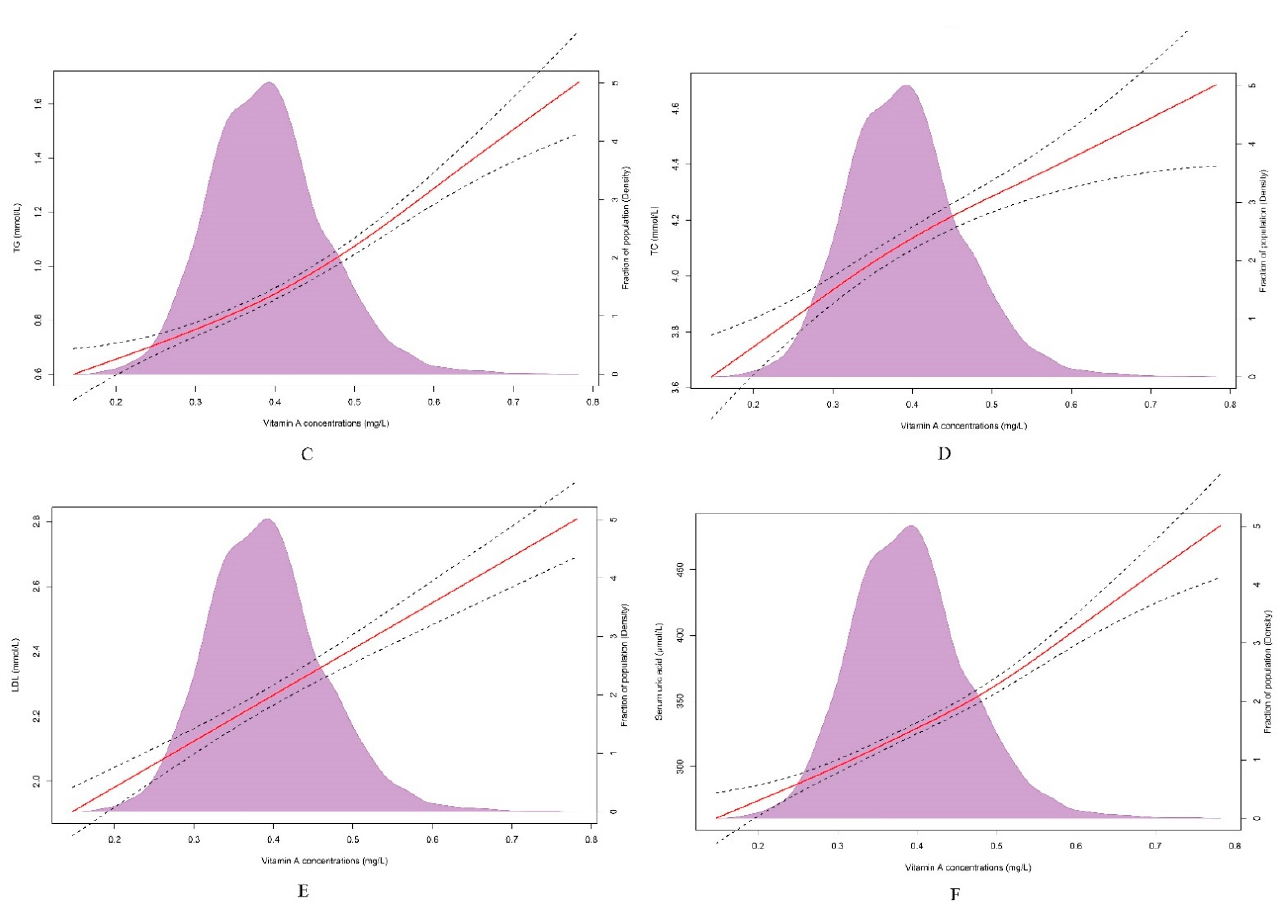
Figure 1. Dose-response curves with 95% confidence interval (CI) were modelled for the associations of serum vitamin A and numerous metabolic risk factors by the generalized additive model (GAM). ( A ). the association between vitamin A concentrations and WC. ( B ). the association between vitamin A concentrations and BMI. ( C ). the association between vitamin A concentrations and TG. ( D ). the association between vitamin A concentrations and TC. ( E ). the association between vitamin A concentrations and LDL. ( F ). the association between vitamin A concentrations and SUA. Abbreviations: waist circumference (WC), body mass index (BMI), triglyceride (TG), total cholesterol (TC), low-density lipoprotein cholesterol (LDL), serum uric acid (SUA). Furthermore, we conducted a stratification logistic analysis by sex in Supplementary Tables S1 and S2. Both in male and female participants, the risk of prevalent MetS, general obesity, high LDL, high TC and hyperuricemia still increased with vitamin A